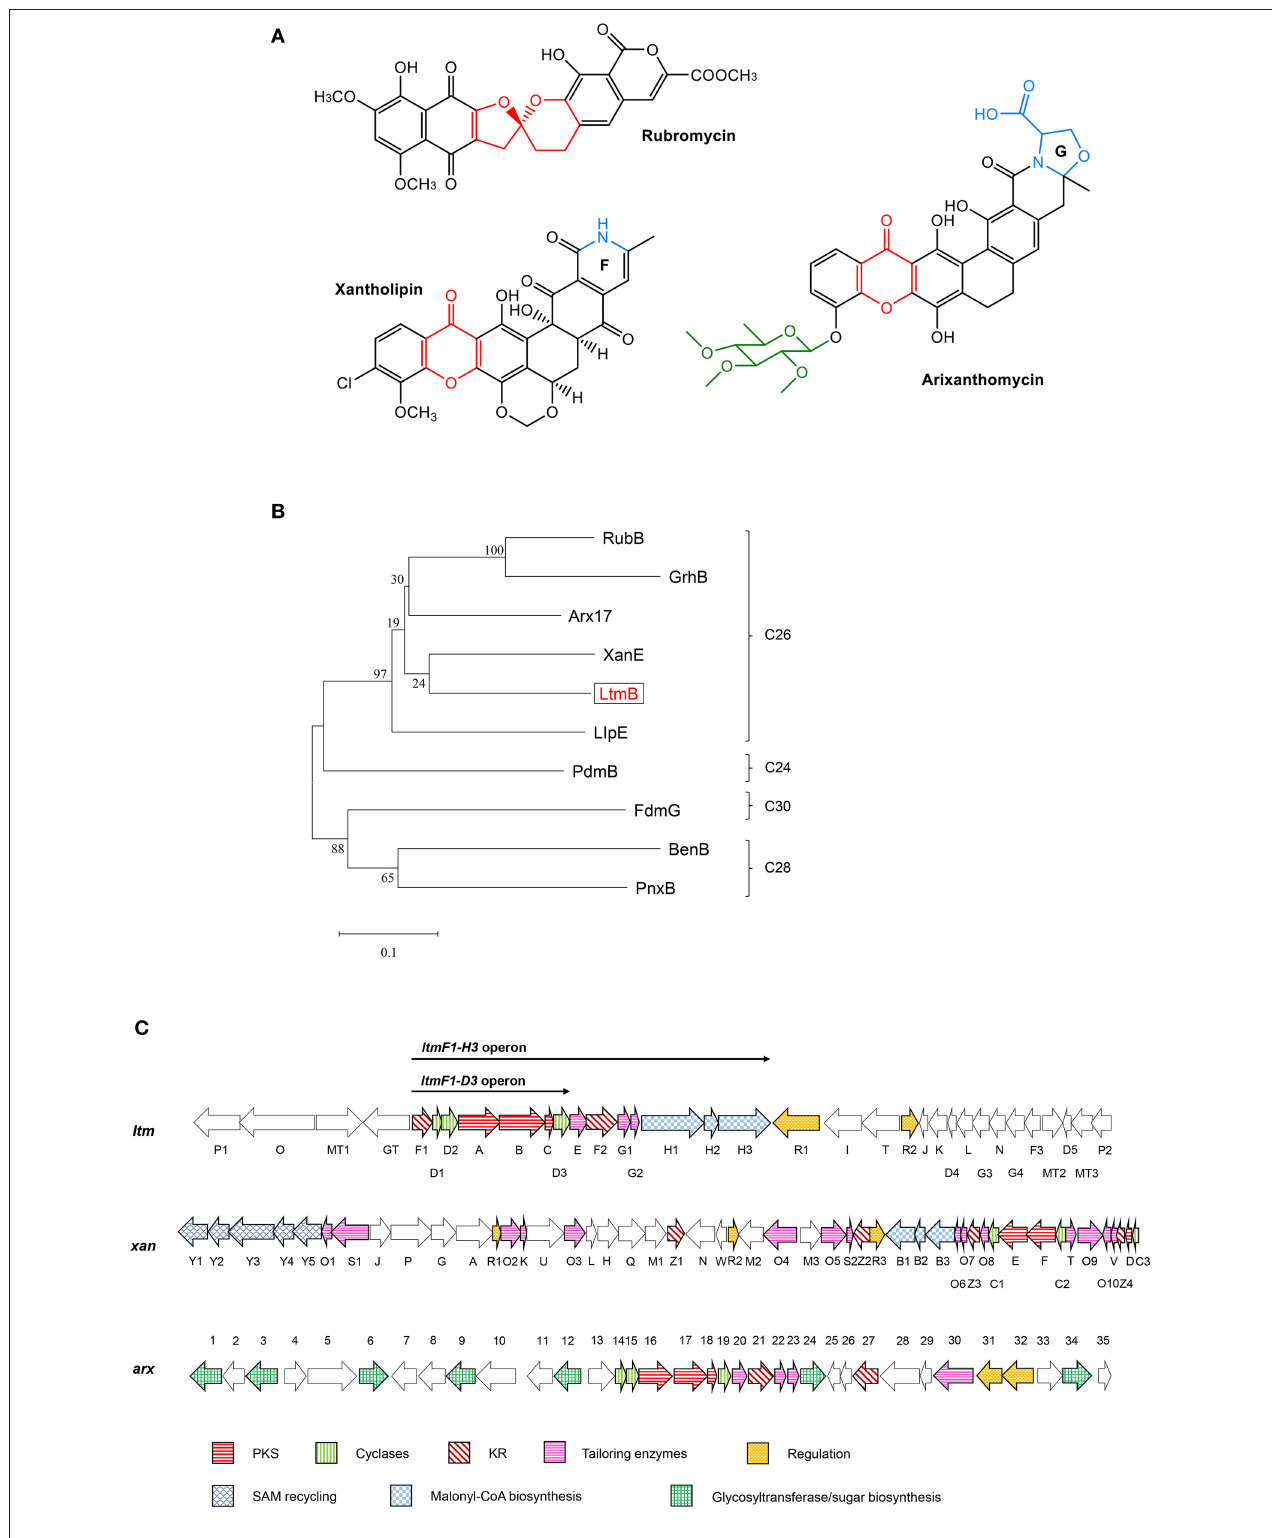
FIGURE 1 | Comparative analysis of the lanthomicin biosynthetic gene cluster. (A) Examples of compounds belong to the pentangular polyphenol subfamily. (B) The maximum likelihood tree of LtmB with homologous KS β proteins from the well-studied pentangular polyphenol clusters. These KS β units could be divided into four groups according to the carbon chain length of their products. (C) ltm cluster was indicated by comparison with xan and arx clusters. The operons for promoter engineering were also indicated in the figure.